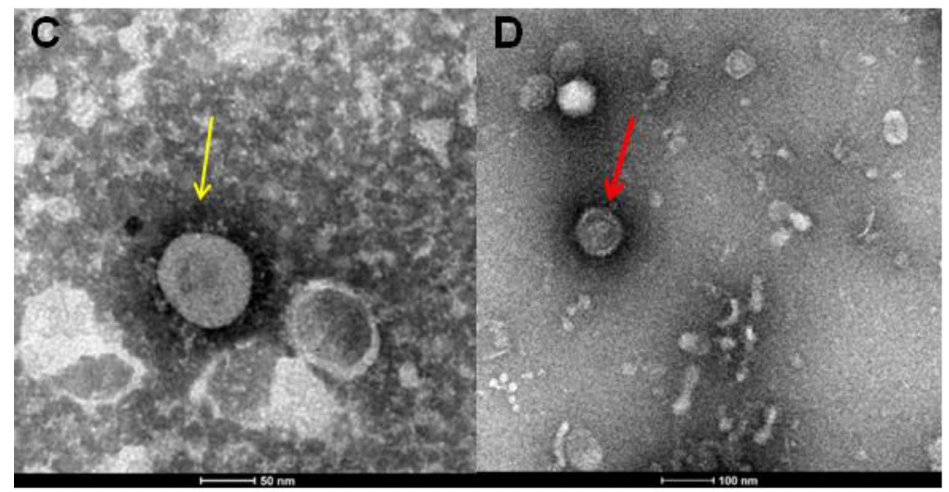
Figure 10. TEM analysis. TEM images of HSV-1 ( A , B ), as well as SARS-CoV-2 ( C , D ) virions. In ( A ), yellow arrows show the untreated HSV-1 particles. In ( C ), spike proteins of untreated SARS-CoV-2 virions are indicated by yellow arrows. In ( B , D ), red arrows show naked particles of HSV-1 and SARS-CoV-2, respectively, treated with 25 µ M of